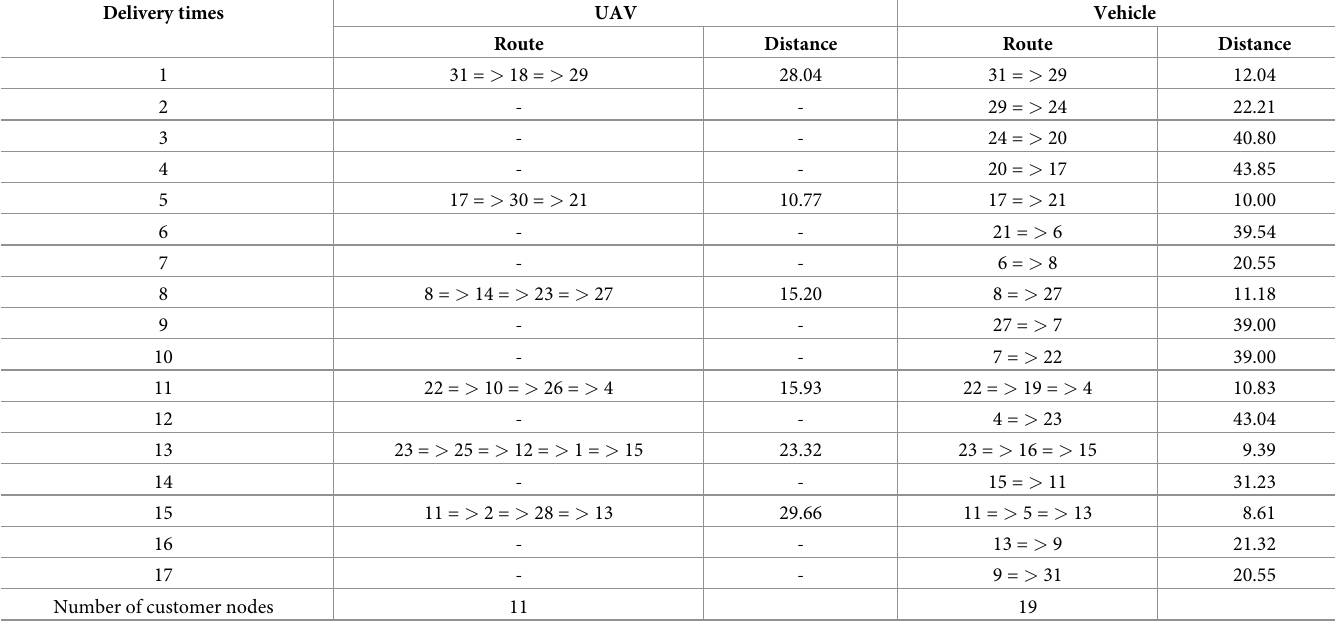
Table 3. Case simulation results.